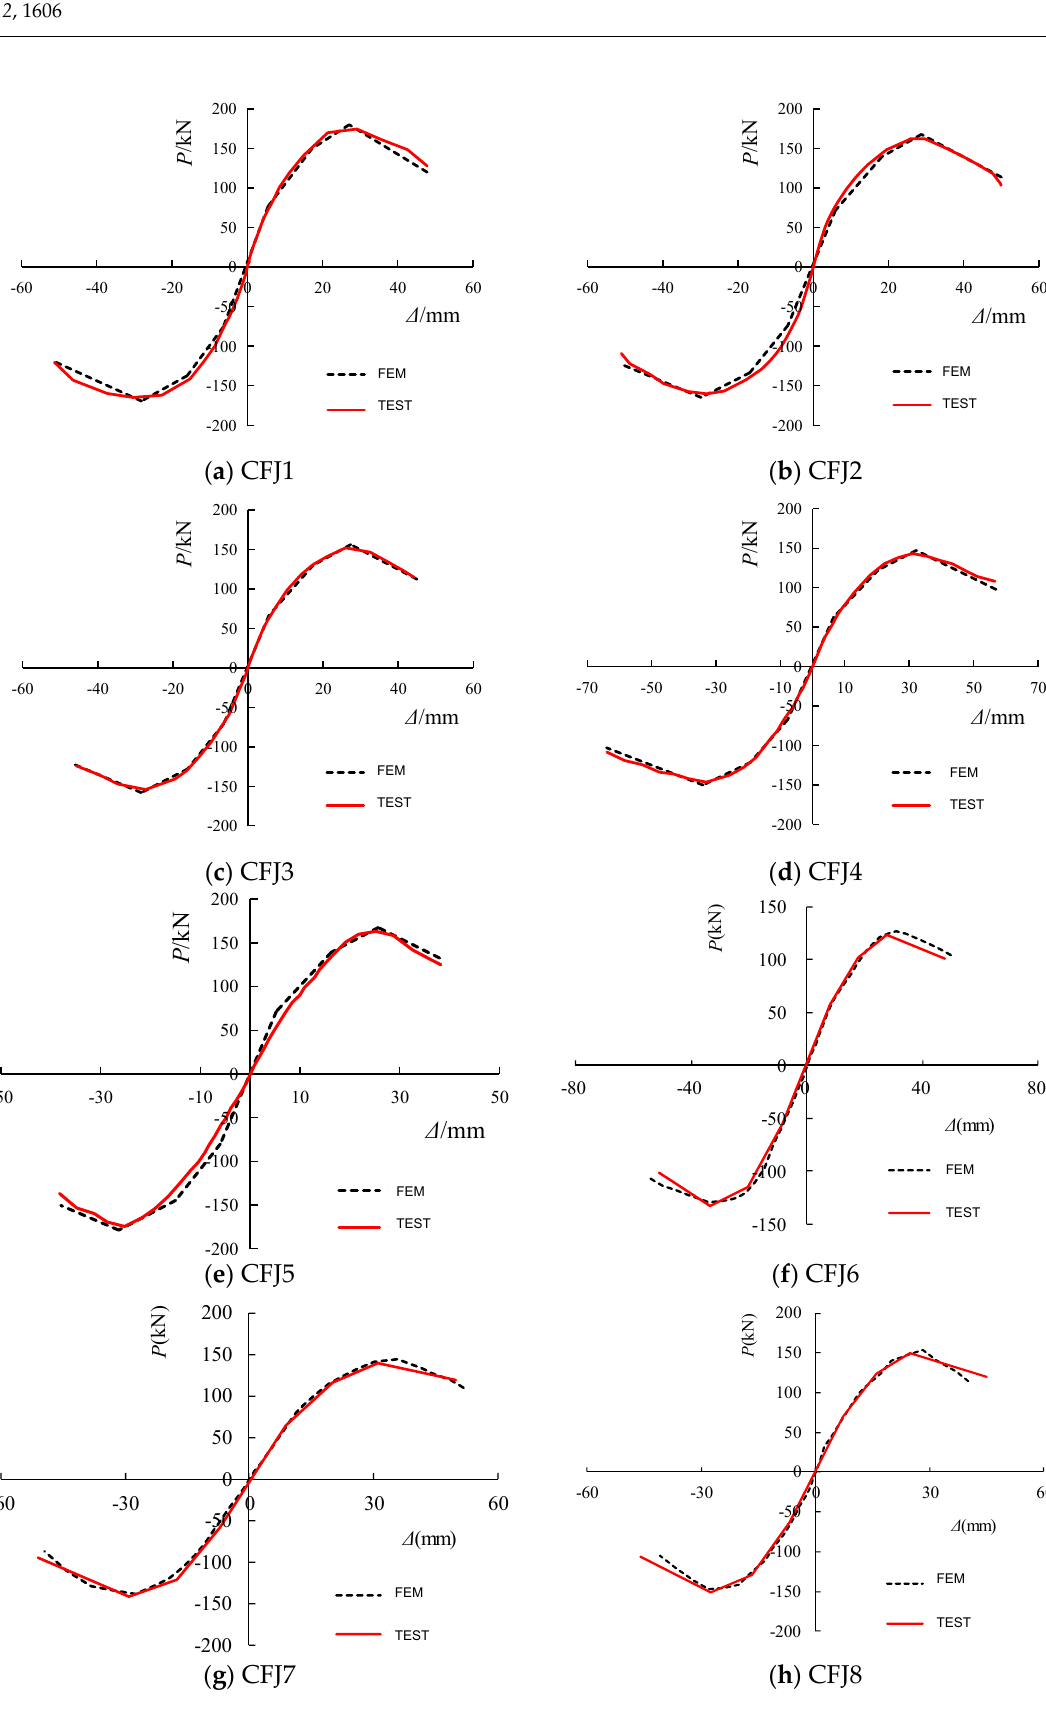
Figure 26. Comparison of skeleton curve between calculation results and test results.